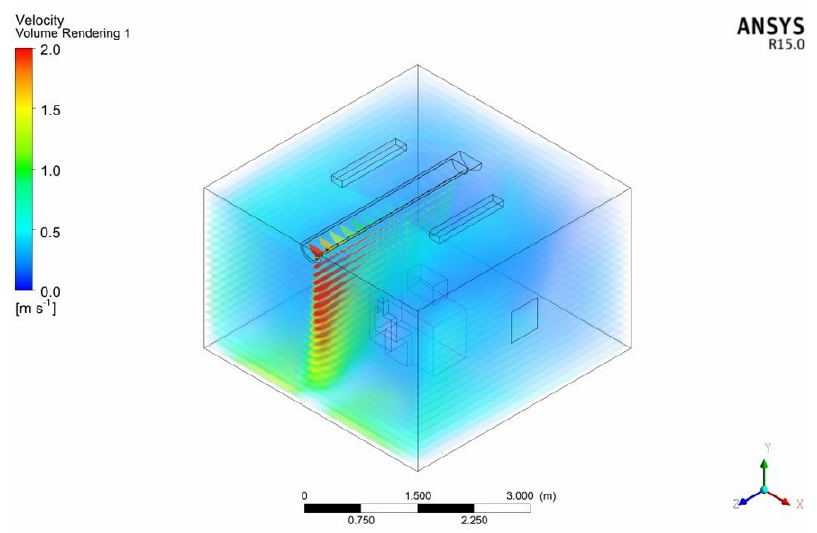
Figure 6. The schematic diagram of the air supply of the single-row hole split-fiber air conditioner.